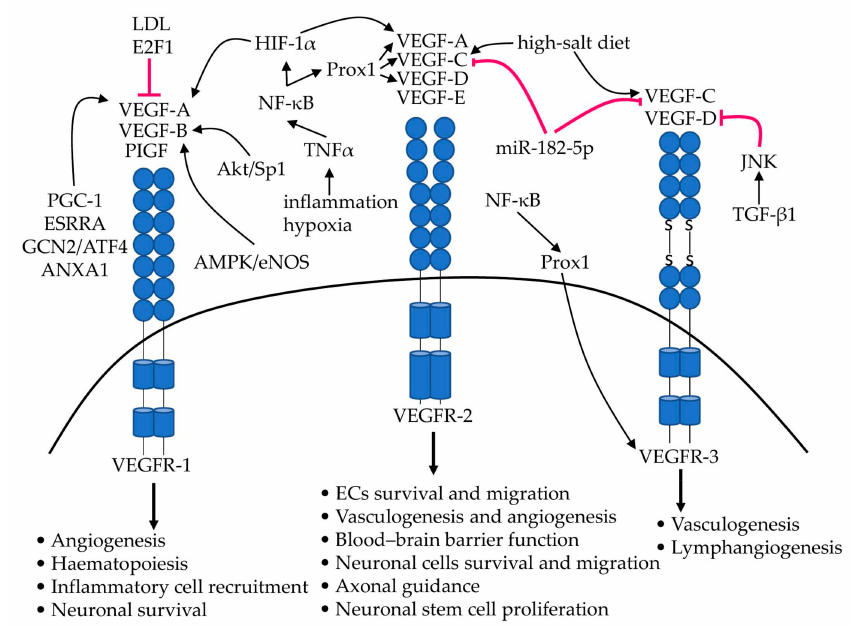
Figure 2. The VEGF family of growth factors. The main VEGF isoforms (VEGF-A, VEGF-B, VEGF-C, VEGF-D and PlGF) and their target the receptor tyrosine kinases (VEGFR-1, VEGFR-2 and VEGFR-3). The key regulatory pathways described in the text and significant effects on receptor-expressing cell types are